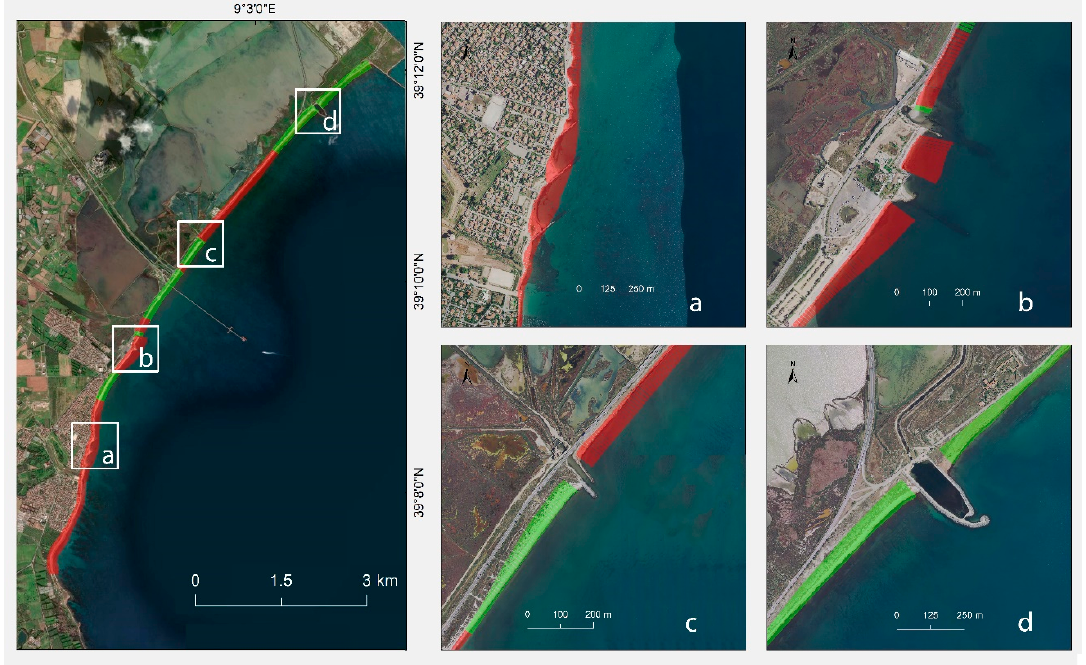
Figure 9. Simplified presentation of accretion and erosion trends normalized to SCE values, showing shoreline changes in the proximity of the main human-made structures found along the Giorgino coastline: ( a ) protection groynes; ( b ) breakwaters in the proximity of Rio Santa Lucia outlet (Figure 3); ( c ) breakwaters along artificial water pump channel (Idrovora del Ponte Vecchio); ( d ) breakwaters along lagoon mouth.